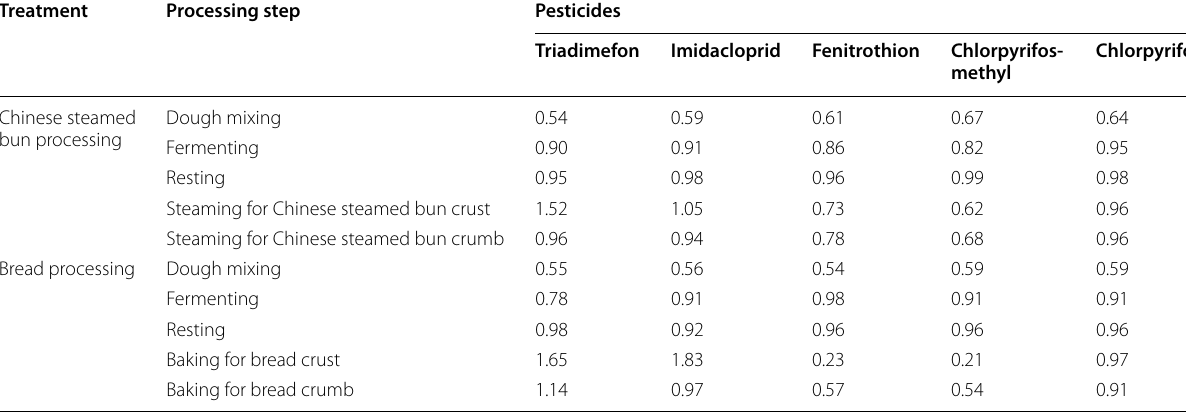
Table 3 Processing factors of the five pesticides for different processing steps